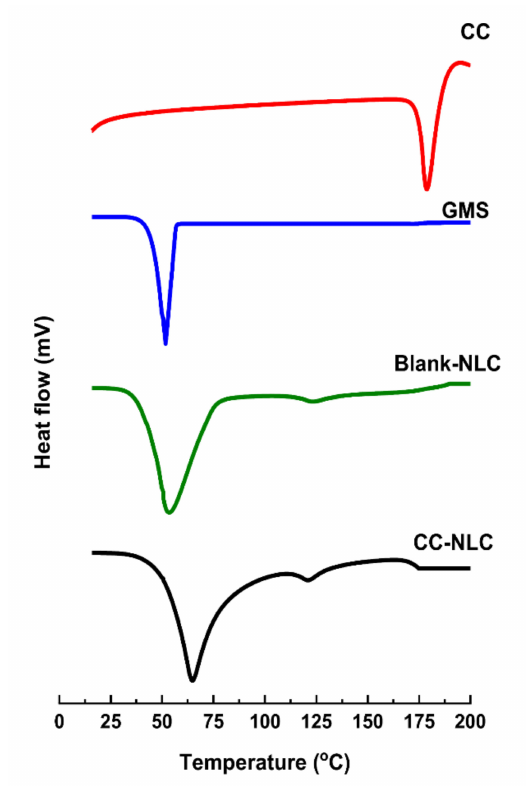
Figure 1. DSC thermograms of CC, GMS, blank-NLC, and